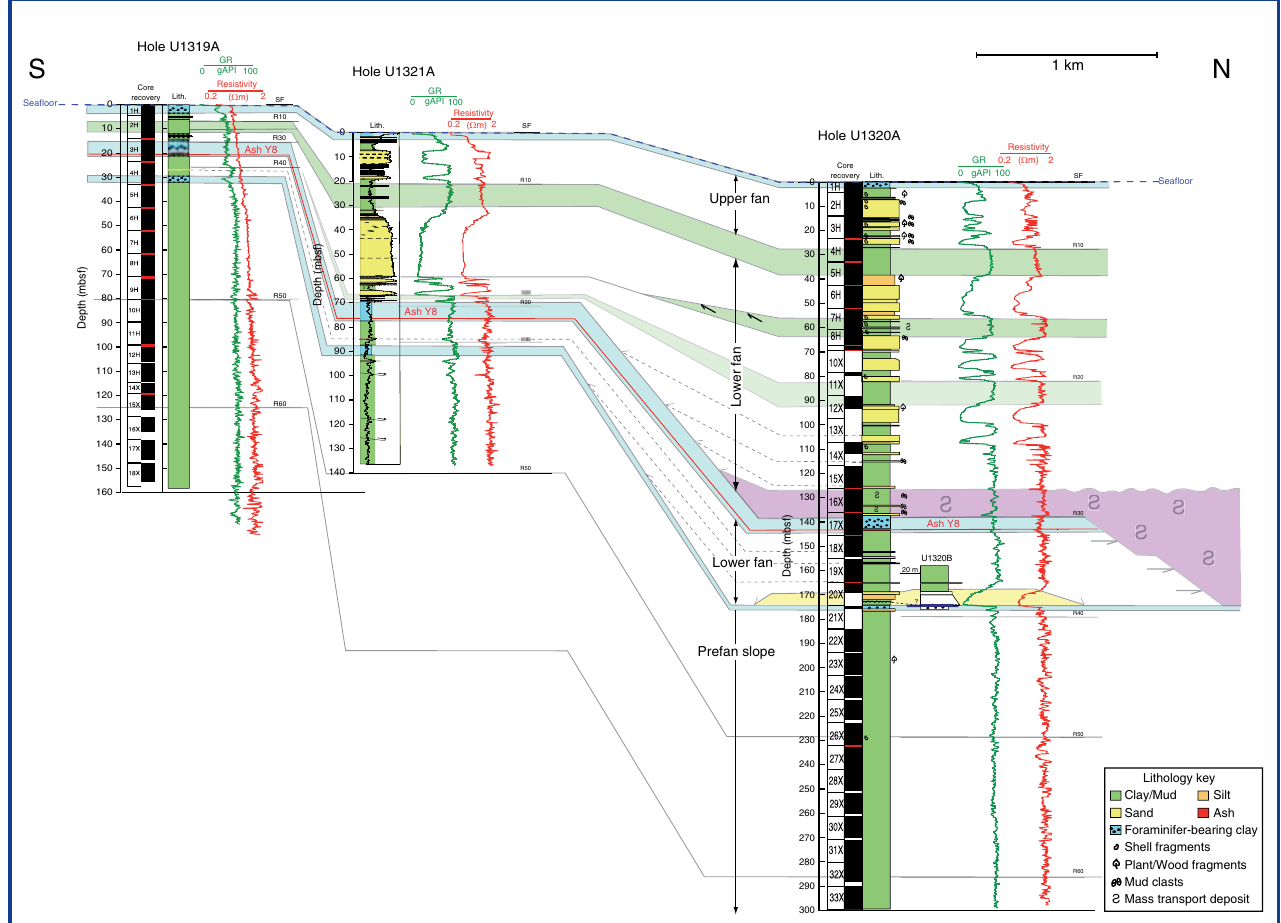
Figure 4. Stratigraphic cross-section of Brazos-Trinity Basin IV. Data of core and well logs are at sea level. Stratigraphic ties between sites are based on seismic, lithology, log signature, and biostratigraphy. Each column contains depth scale, schematic lithology, gamma ray (GR) and resistivity logs (from LWD data), and depth of key seismic surfaces. In core recovery diagram, black = cored, red = overlap due to core expansion, and white = no recovery. mbsf = meters below sea fl